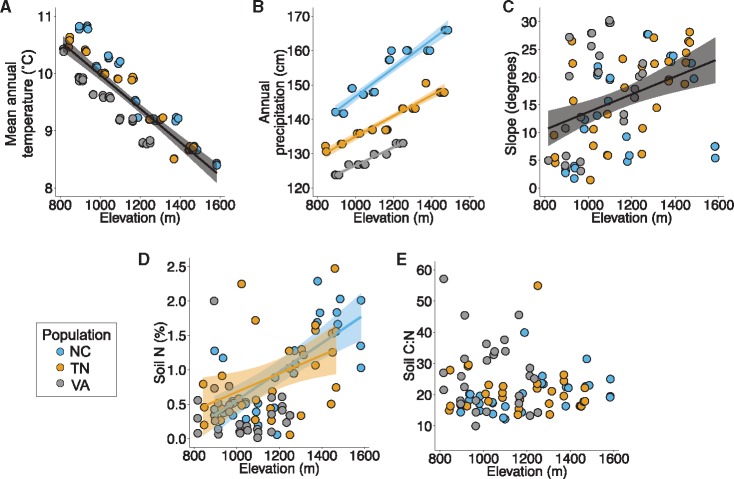
Variation in five climatic, topographic, and edaphic variables along elevation in three Rhododendron maximum populations (North Carolina [NC, blue]; Tennessee [TN, orange]; Virginia [VA, grey]). A solid black line indications a significant (P < 0.05) effect of elevation across populations (no population-by-elevation interaction). When statistical models detected significant population-by-elevation interactions, coloured regression lines corresponding only to those populations in which traits varied significantly (P < 0.05) along elevation are shown. The shaded region around each line represents the 95 % confidence interval for that regression.